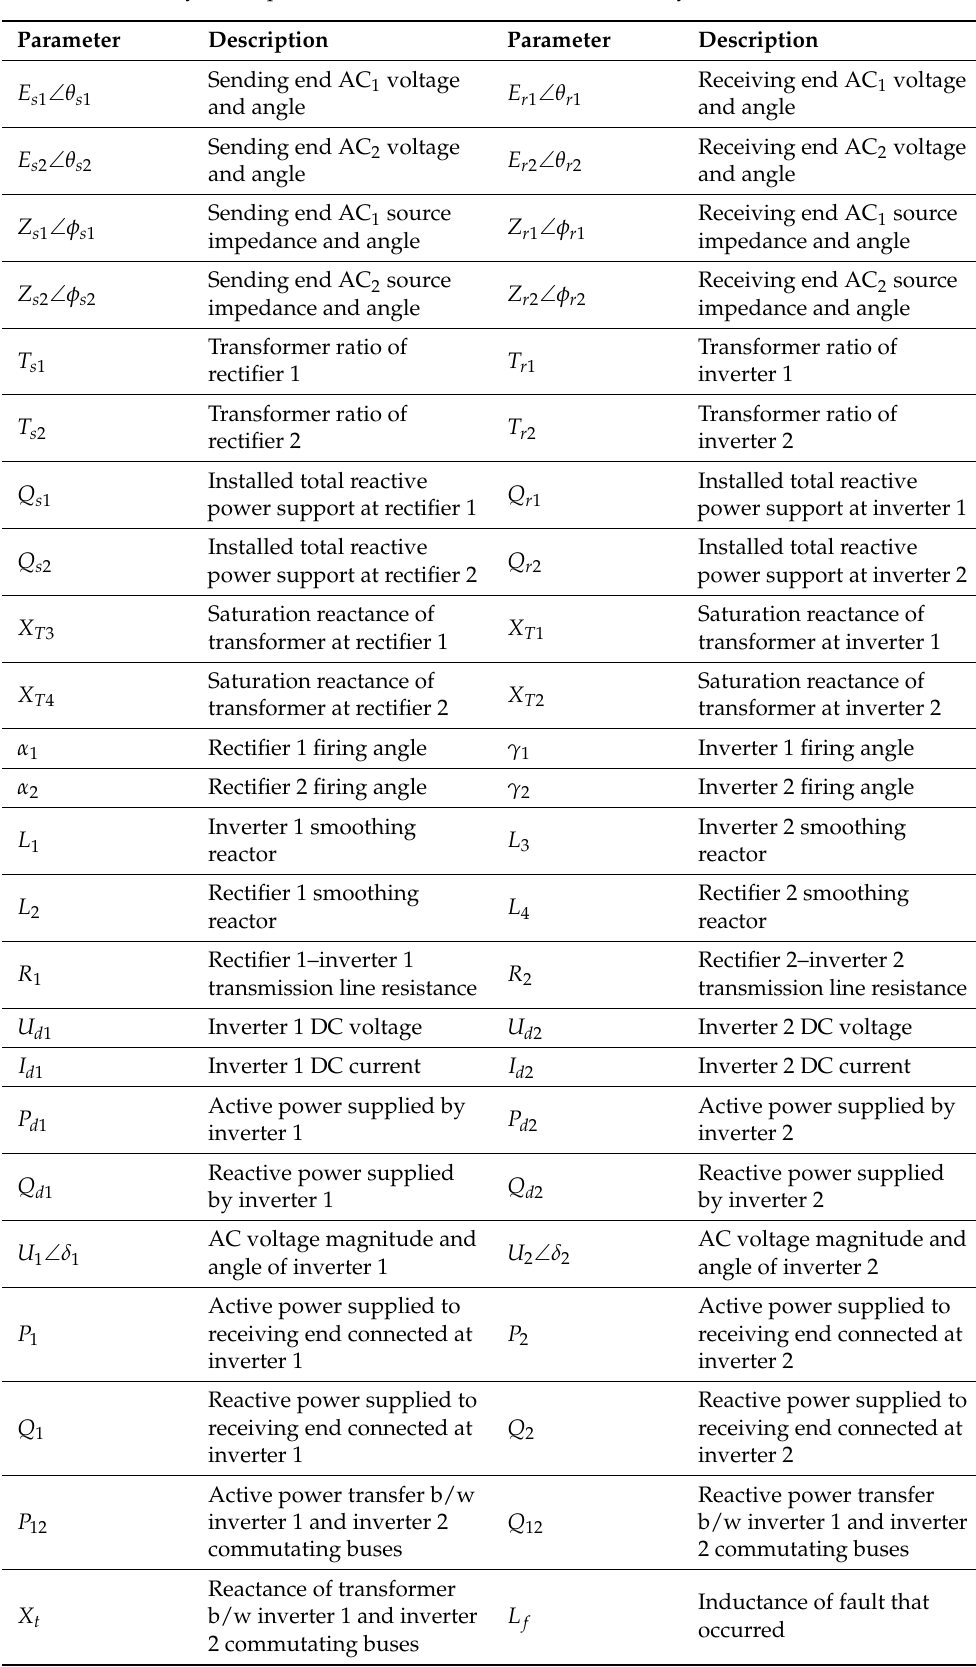
Table 2. Basic analytical expressions of a multi-infeed LCC–HVDC